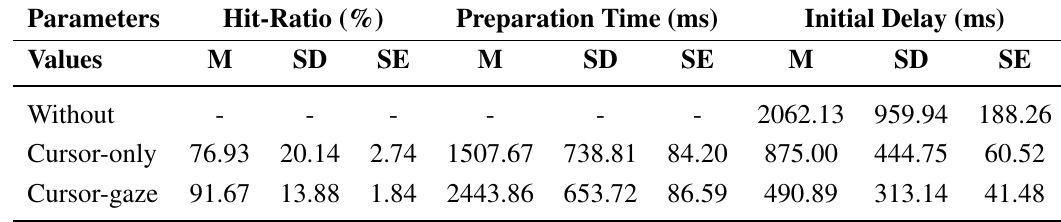
Table 2. Summarized performance of the proposed user intention prediction methods.